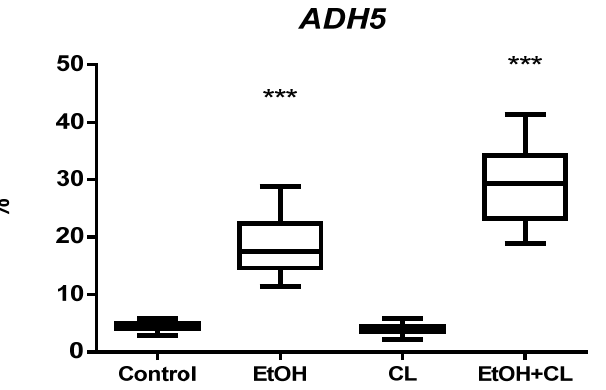
Figure 11. Levels of ADH5 expression in hepatocytes of rats. *** ( p ≤ 0.0005)—in comparison with the parameters of animals of the control group.